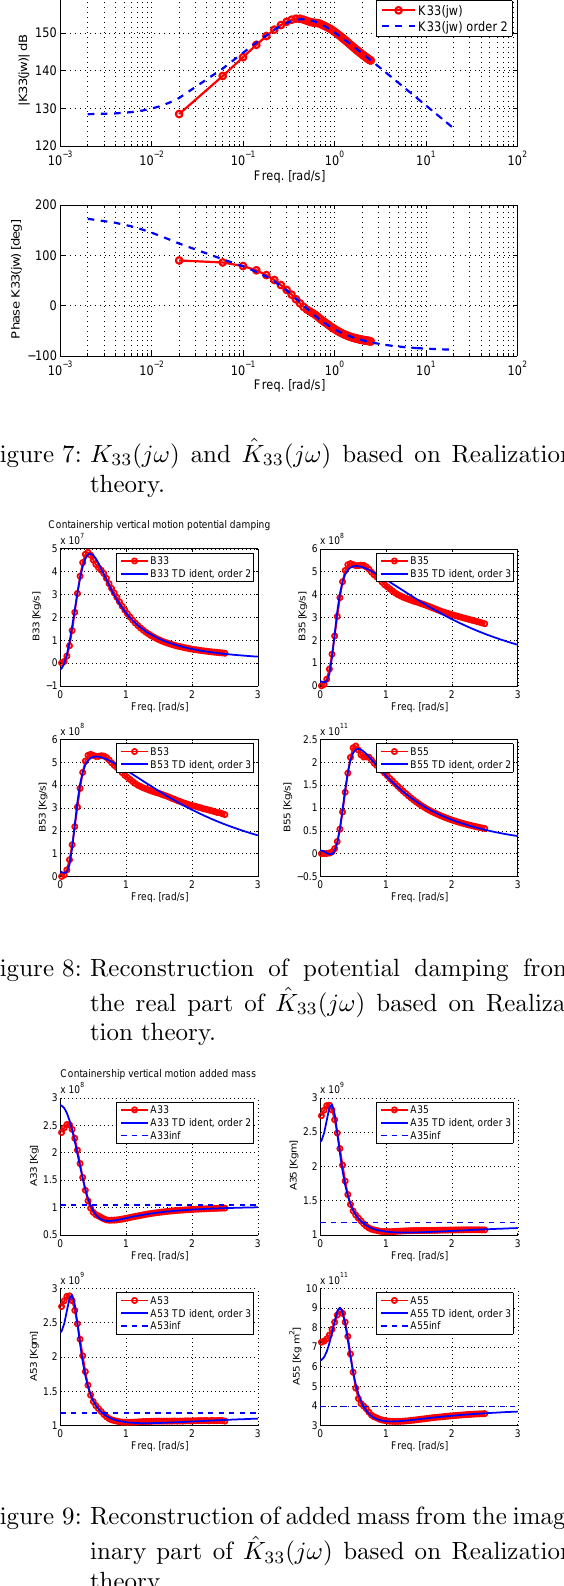
Figure 9: Reconstruction of added mass from the imag- inary part of ˆ K 33 ( jω ) based on Realization theory.